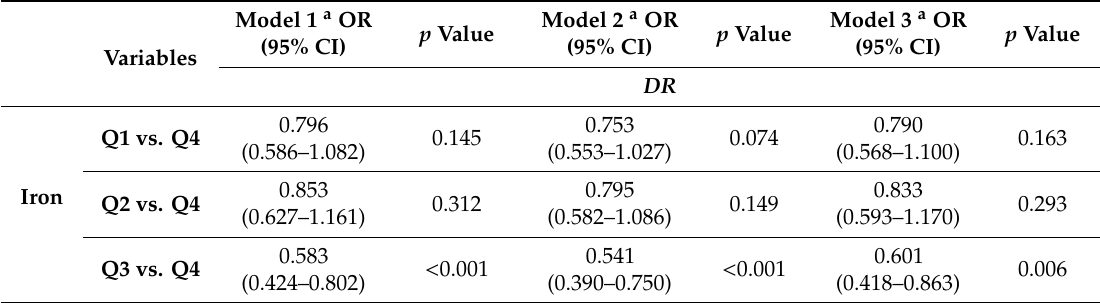
Table 4. Relationship of di ff erent quartiles of iron with